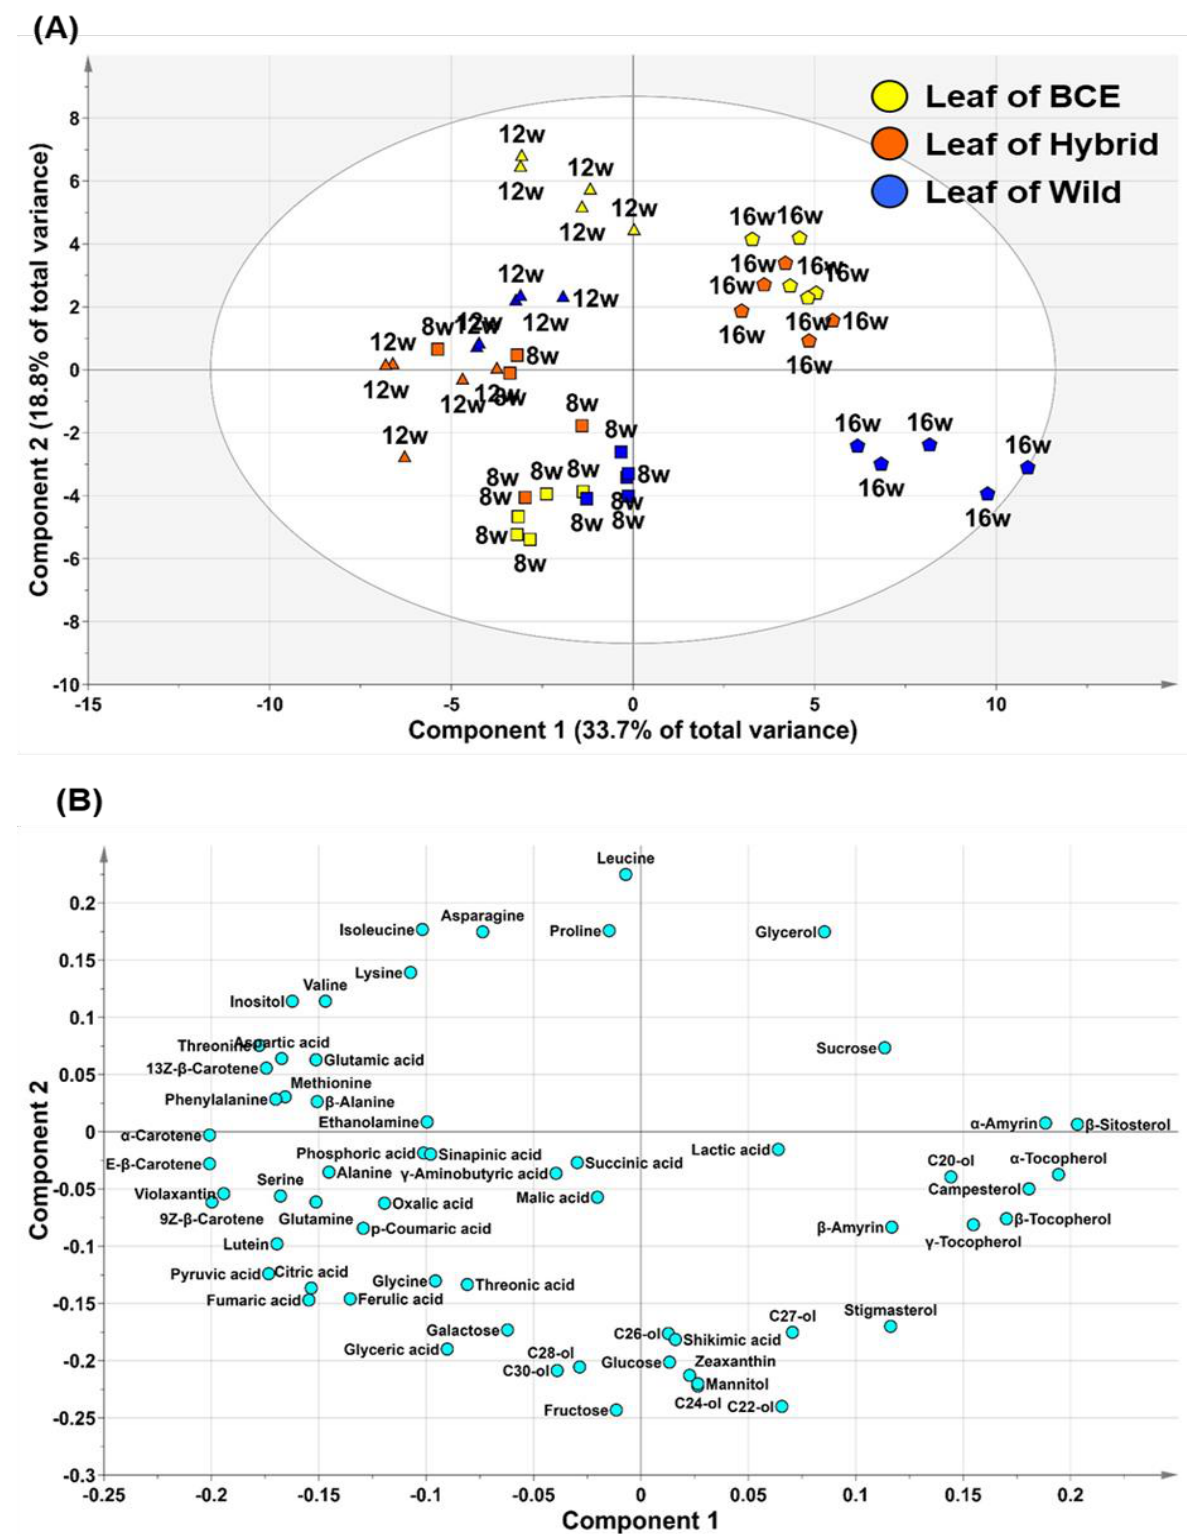
Figure 4. Score ( A ) and loading ( B ) plots of PCA of metabolites extracted from BCE, Hybrid, and Wild leaves. Squares, triangles, and pentagons represent 8, 12, and 16 weeks, respectively.